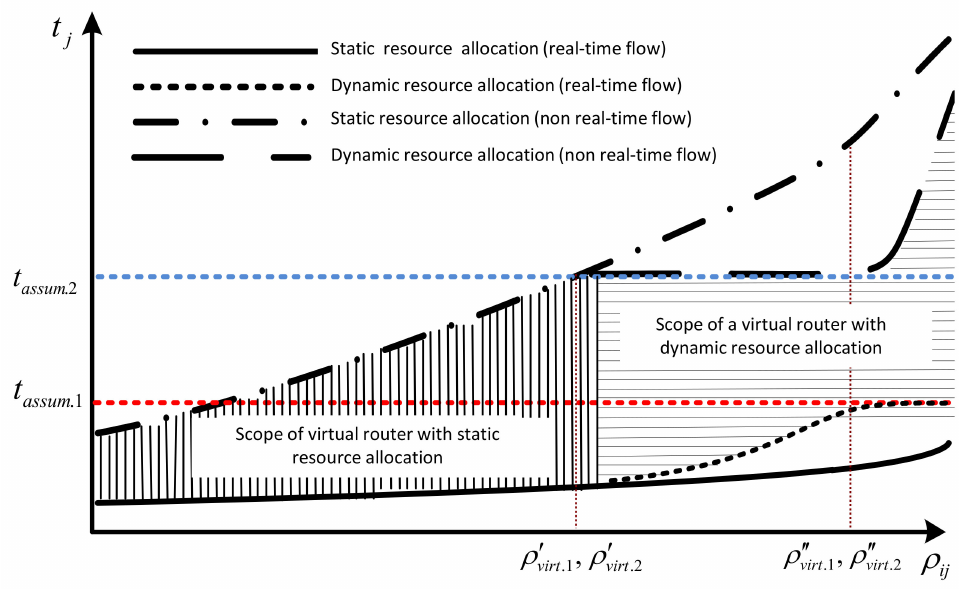
Figure 2. The principle of static and dynamic allocation of computing resources of a network device in the organization of virtual class-service